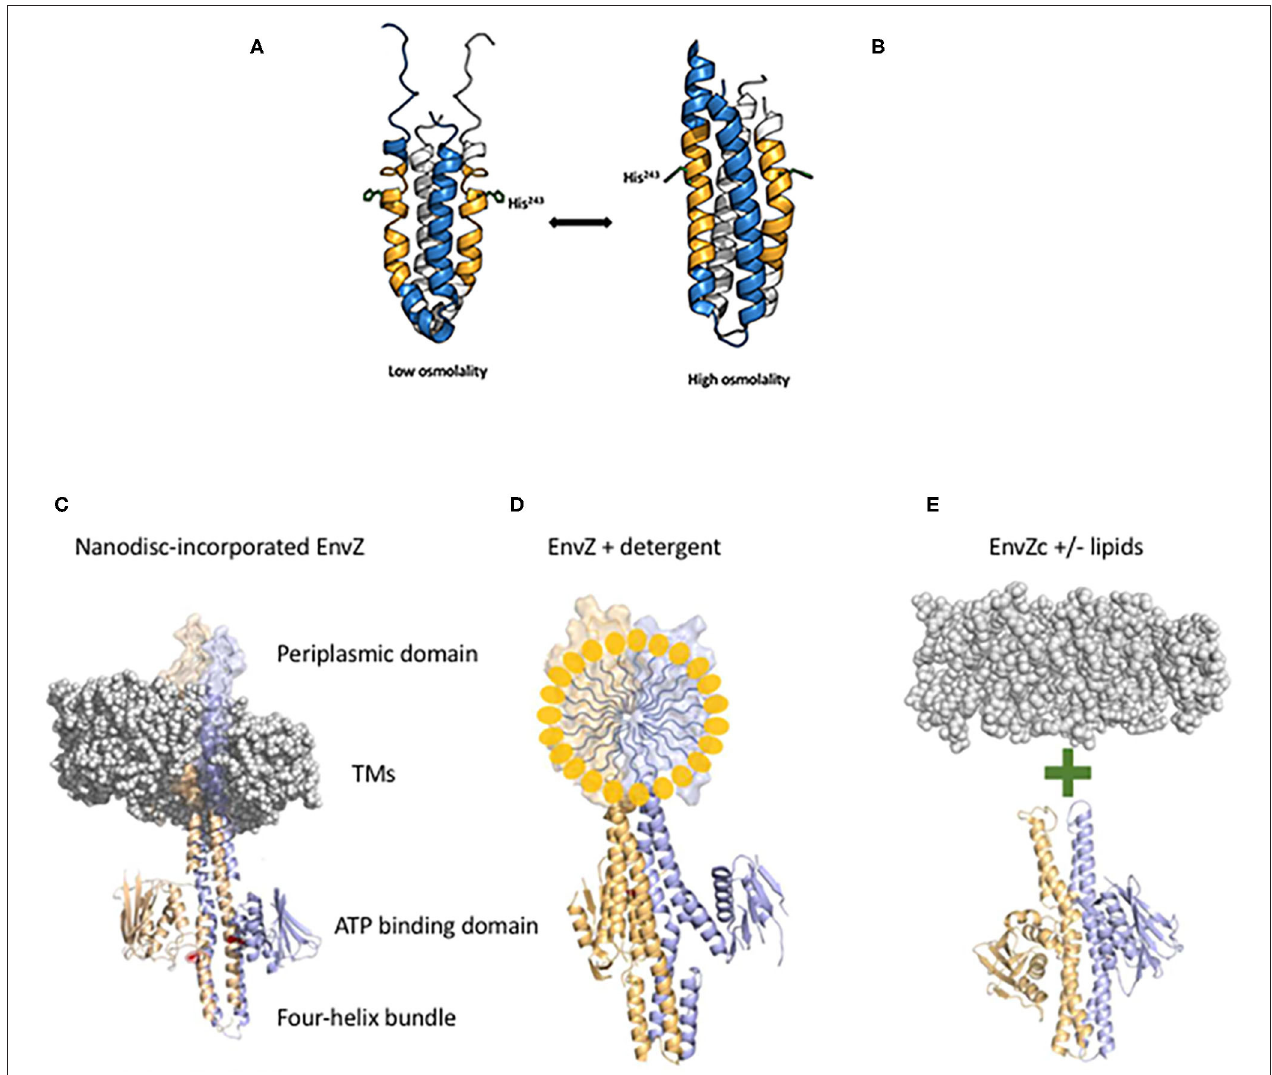
FIGURE 2 | EnvZc four-helix bundle subdomain structure at low osmolality (A) and at high osmolality (B) . The low osmolality structure was composed of residues 223–289 and was solved by NMR (PDB ID:1JOY) (Tanaka et al., 1998), the high osmolality structure was a chimera of EnvZ with the Archaeoglobus fulgidus Af1503 HAMP domain (PDB ID:4CTI) (Ferris et al., 2014). The amber peptide was identified from HDXMS analysis highlighting the change from poorly ordered to highly ordered during the switch from low to high osmolality (Wang et al., 2012). The sidechain of the histidine that is phosphorylated (His 243 ) is shown in stick form. At low osmolality, His 243 is positioned by a coordinated relay of interactions from the backbone carbonyl of Ala 239 (one helical turn above His 243) through the imidazole side chain of His 243 to the carboxylic acid side chain of Asp 244 . Intrinsic disorder within the amber peptide affords a low basal level of autophosphorylation. High osmolality stabilizes the helical backbone and relieves the Ala 239 carbonyl link to anchor the His 243 imidazole by a H-bond with Asp 244 at the N δ of His 243 . This enables phosphotransfer to the N ε of His 243 [see Kenney and Anand (2020) for more details]. Thus, the core of osmosensing is a His-Asp/Glu dyad positioned within a flexible helix. Various EnvZ constructs employed in the study. (C) The EnvZ periplasmic domain protrudes above the membrane (shown as a space filling model PDB ID:3J00, the EnvZ dimer is from PDB ID:4CTI). The transmembrane domains (TMs) connect to the four-helix bundle formed from a dimer of two monomers shown in lavender and pale orange. A single His 243 side chain is highlighted in red (phosphorylation site) and the ATP binding domains flank His 243 [from Kenney and Anand (2020)]. (D) Full-length EnvZ solubilized in detergent micelles for comparison with nanodiscs and E. coli lipids. (E) The activity of EnvZc alone (bottom) was compared with EnvZc in the presence of lipids (see Table 1